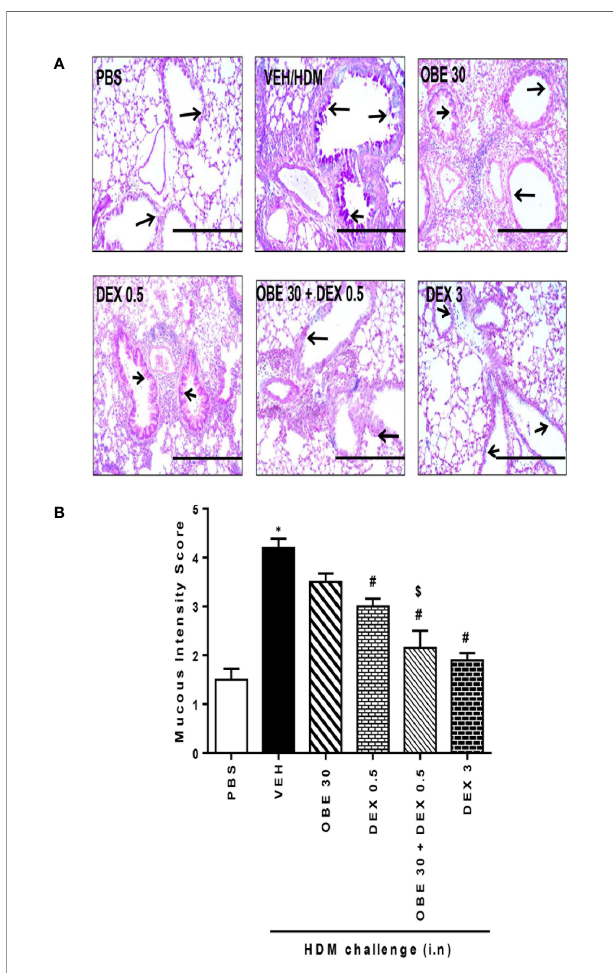
FIGURE 11 | Effect of OBE (30 mg/kg; i.p.) both alone and in combination with low dexamethasone (0.5 mg/kg) on HDM-induced bronchial mucous production and goblet cell hyper/metaplasia. (A) Representative low- magni fi cation light photomicrographs displaying PAS staining of whole lung samples from control PBS-challenged mice (PBS), HDM-challenged mice (HDM), HDM-challenged mice pretreated with OBE (30 mg/kg; i.p.) (OBE 30), HDM-challenged mice pretreated with low dose dexamethasone (0.5 mg/kg; i.p.) (DEX 0.5), HDM-challenged mice pretreated with a combination of OBE (30 mg/kg; i.p.) and low dose dexamethasone (0.5 mg/kg; i.p.) (OBE 30 + DEX 0.5), HDM-challenged mice pretreated with high dose dexamethasone (3 mg/kg; i.p.) (DEX 3), scale bar = 200µm. Graphs show (B) mucous intensity score. OBE treatment in combination with low dose dexamethasone resulted in a signi fi cant decrease in bronchial mucus production and goblet cell hyper/ metaplasia compared to either treatment when give alone. Data are expressed as mean ± SEM ( n = 5). *P < 0.05 vs PBS and # P < 0.05 vs HDM and $ P < 0.05 versus either OBE (30 mg/kg; i.p.) alone group or dexamethasone (0.5 mg/kg/i.p.) alone